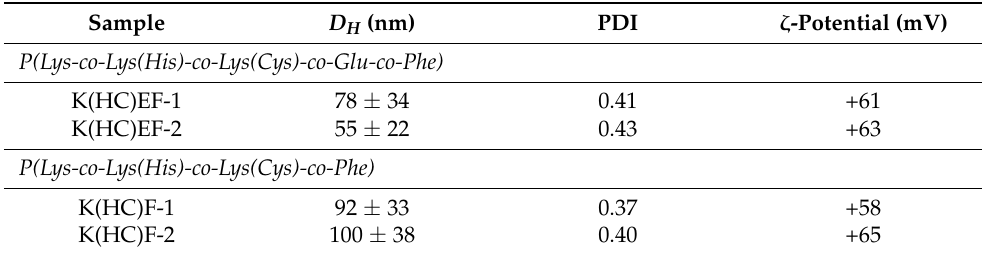
Table 2. Physicochemical parameters of the nanoparticles in